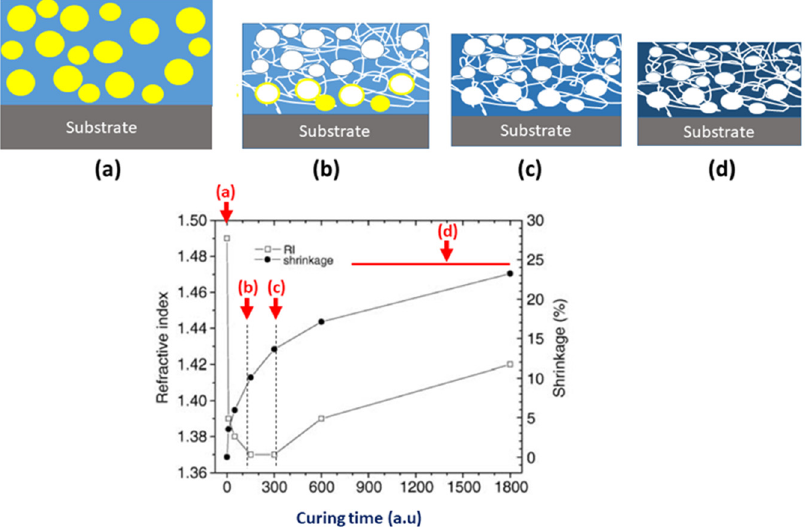
Figure 1. Changes in the low-k thickness and refractive index during the curing of a porogen-based low-k film. The curing curve is partially redrawn from [9]. The curing time is represented in arbitrary units because it depends on conditions. The region between the dashed curves corresponds to 1–2 h in pure thermal curing but can be reduced to 5–12 min if the curing is assisted by UV light as in [5]. The sketches in the subfigures ( a – d ) qualitatively visualize the state of the low-k film in the positions ( a – d ) indicated by the arrows in the main part of the figure. ( a ) The film before curing (soft baked film). ( a , b ) The removal of porogen causes the reduction in RI and thickness of the film. ( b , c ) The porogen is removed, but some residues can remain. ( c , d ) The matrix densification related to the dissociation of some Si-CH 3 bonds and the collapse of a part of the nanopores causes increase in RI.